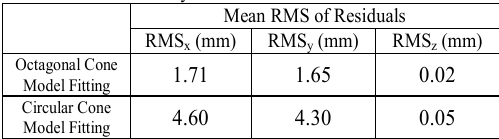
Table 8. Comparison of the mean RMS of the residuals of the octagonal and circular cone models fitting with the real data (Poles 1 - 3) captured by the Faro Focus 3D Mean RMS of